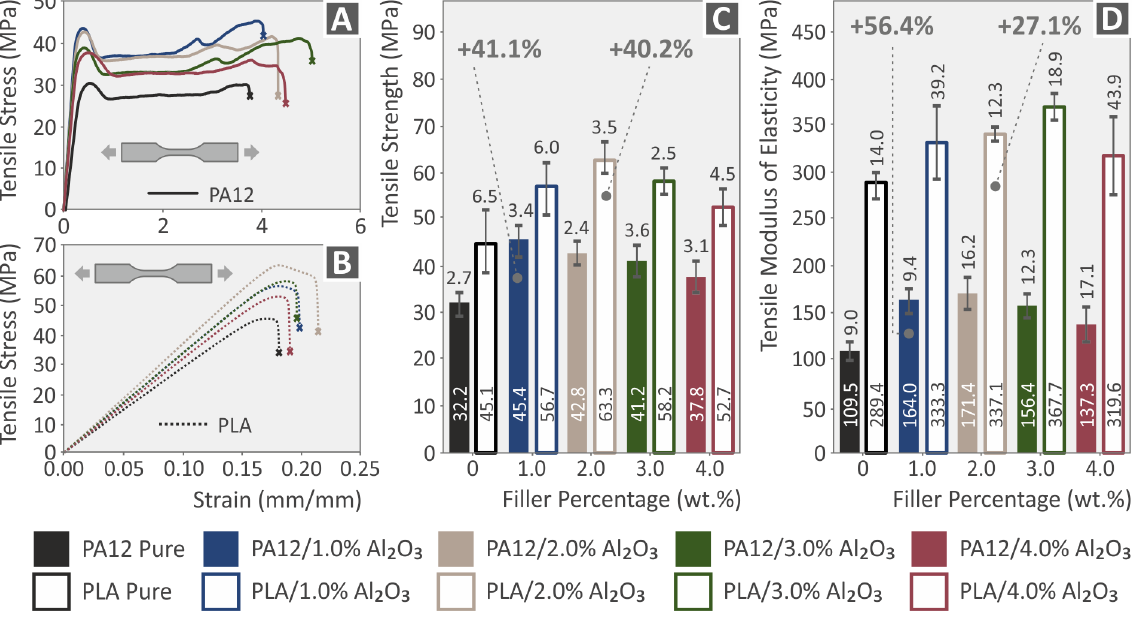
Figure 13. ( A , B ) Tensile stress (MPa) vs. strain (%) stress–strain curves for PA12 and PA12/Al 2 O 3 nanocomposites, as well as for PLA and PLA/Al 2 O 3 nanocomposites; ( C , D ) Tensile strength and tensile modulus of elasticity for 3DP PA12, PLA and all nanocomposites at 1.0, 2.0, 3.0, and 4.0 wt.% Al 2 O 3 filler loading. Legend shows which color corresponds to which material in each graph.